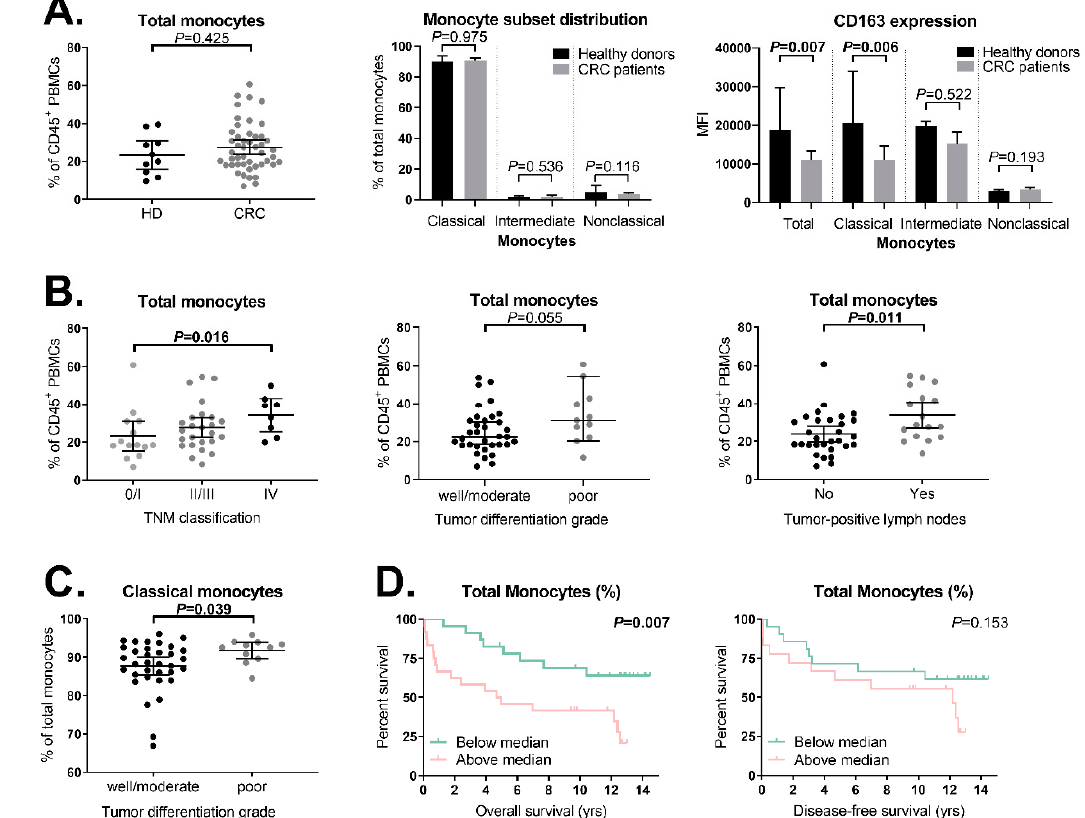
Figure 3. Distribution of monocyte subsets and their level of CD163 expression in the peripheral blood of CRC patients and healthy donors as measured by flow cytometry in relation to clinicopathological parameters ( A ) Comparison of the total monocyte percentage, monocyte subset distribution (CD14 ++ CD16 − classical, CD14 ++ CD16 + intermediate and CD14 + CD16 ++ nonclassical monocytes), and CD163 expression level on these monocyte subsets between healthy donors ( N = 10) and CRC patients ( N = 47). ( B ) Association between the total monocyte percentage and TNM stage (stage 0/I, N = 14; stage II/III, N = 25; stage IV, N = 8), differentiation grade (well/moderate, N = 34; poor, N = 11) and tumor-positive lymph nodes (no, N = 30; yes, N = 17) in CRC patients. ( C ) Association between the percentage of classical monocytes and differentiation grade (well/moderate, N = 34; poor, N = 11) in CRC patients. ( D ) Association between the total monocyte percentage and clinical outcome in CRC patients. Kaplan–Meier curves for the OS are shown for TNM stage 0–IV CRC patients ( N = 47) and Kaplan–Meier curves for the DFS are shown for stage 0–III CRC patients ( N = 39). Stratifications were based on the median total monocyte percentage (24.9%). The bars in figure ( A – C ) show the median with a 95% CI. Statistically significant p -values ( ≤ 0.05) are indicated in bold. Abbreviations: CI